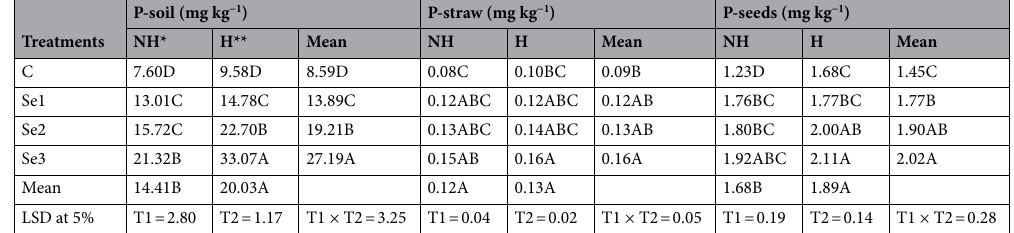
Table 3. Effect of selenium and K-humate on phosphorous content. *Refers to Se application without K-humate. **Refers to the simultaneous application of Se and K-humate.